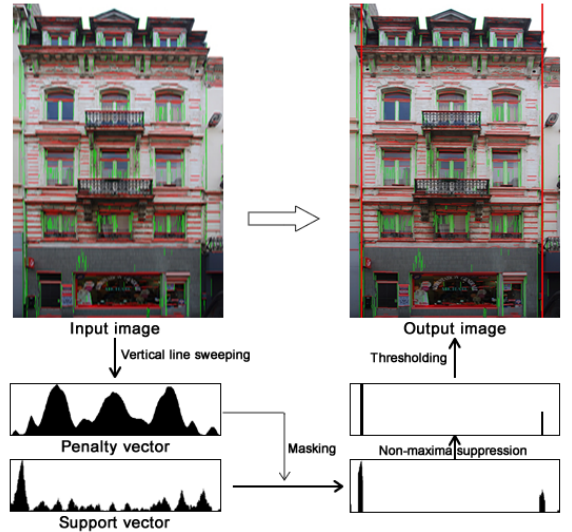
Figure 3: Facade splitting algorithm.